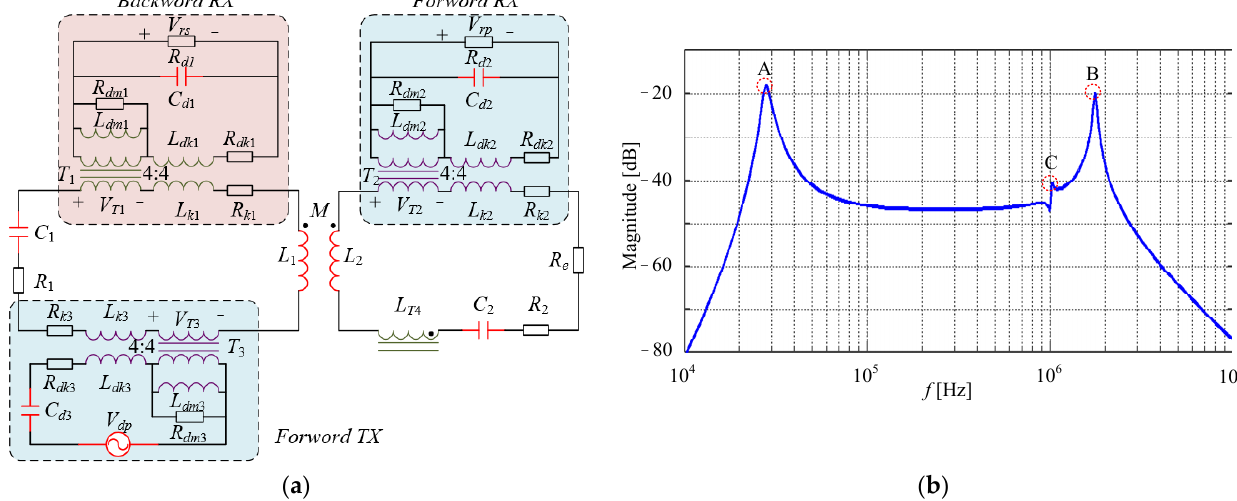
Figure 5. Forward information transfer channel. ( a ) Simplified schematic of the forward transmission channel. ( b ) Bode plot of the forward information transmission.